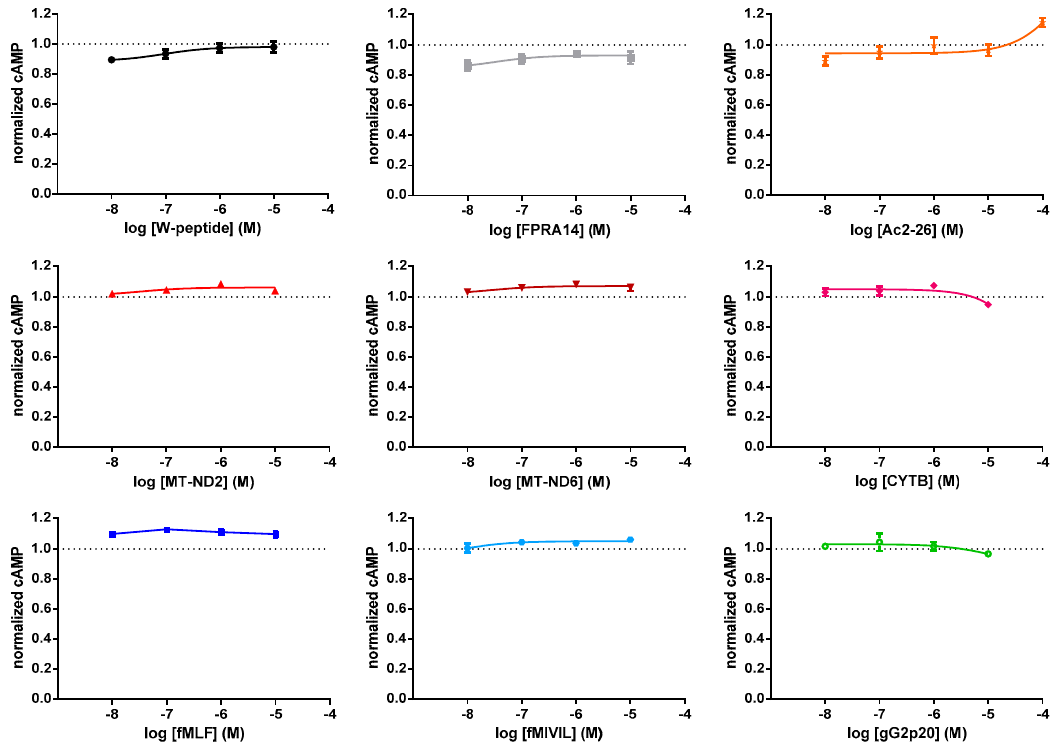
Figure A2. Concentration-response curves for FPR1-mediated stimulation of cAMP production. None of the agonists increased intracellular cAMP levels, in line with the reported FPR1-mediated activation of G α i . Mean response ± SEM, n 3.